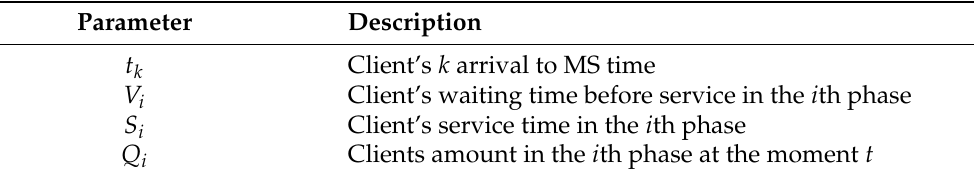
Table 1. Model parameters.